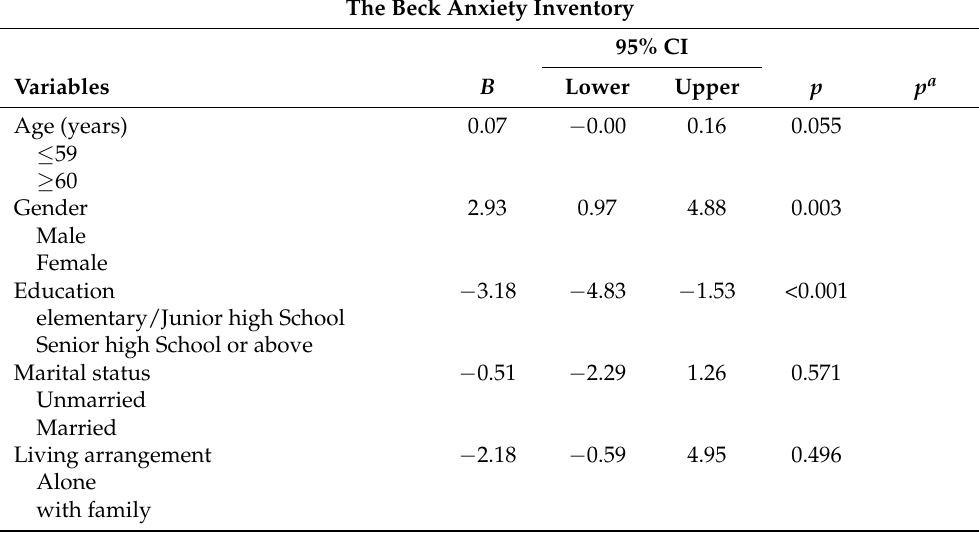
Table 3. Analysis of factors associated with Beck Anxiety Inventory score and sociodemographic characteristics ( n =